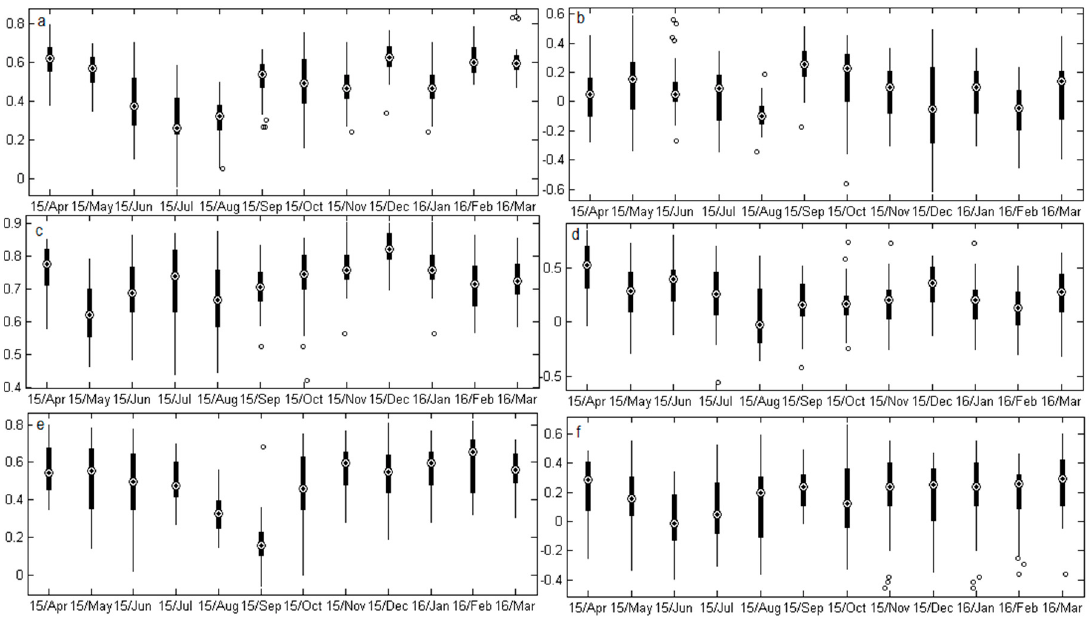
Figure 10. Temporal evolution of correlation between SMAP L4 ( a , c , e ) or AMSR2 L3 ( b , d , f ) daily average data and in situ soil moisture data in the western ( a , b ), central ( c , d ), and eastern ( e , f ) regions of U.S.